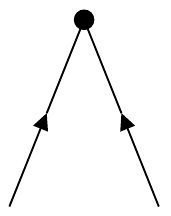
Figure 2 . A two-gluon scattering process at first order in the